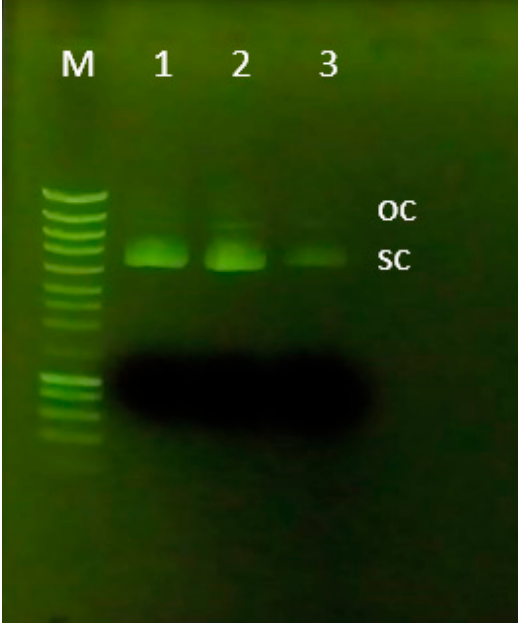
Figure 6. Analysis of the agarose gel electrophoresis of samples collected from each peak in the cation purification assay. Lane M: molecular weight marker; Lane 1: feed sample ( E. coli lysate pre-purified with a commercial kit); Lane 2: pDNA+Tris 10 mM pH 8 chromatographic support; Lane 3: pDNA+ NaCl 2M pH 8 chromatographic support.